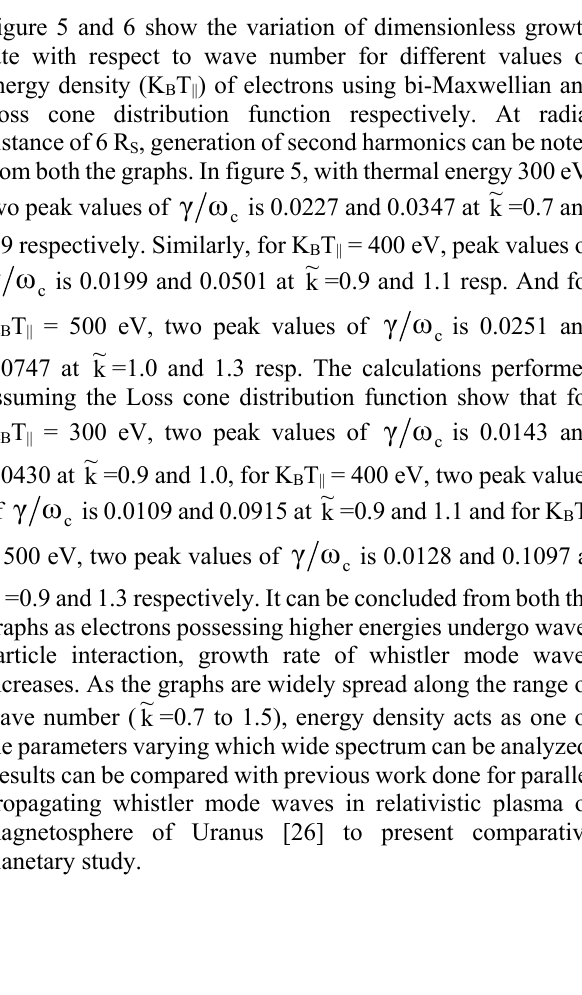
Fig.5: Variation of Growth Rate with respect to various values of K B T || at other plasma parameters being B o = 80 nT, θ =30 o , n o =1x10 6 m -3 and